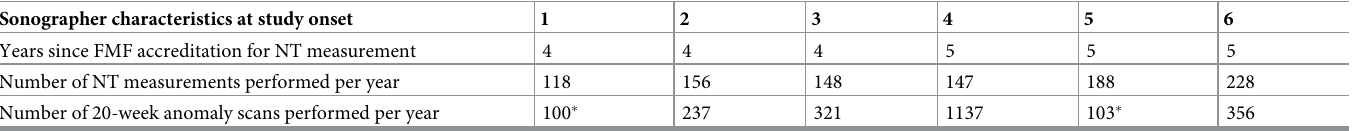
Table 7. The skull and brain had the highest scores for correct anatomical landmarks (skull: Table 3. Characteristics of the